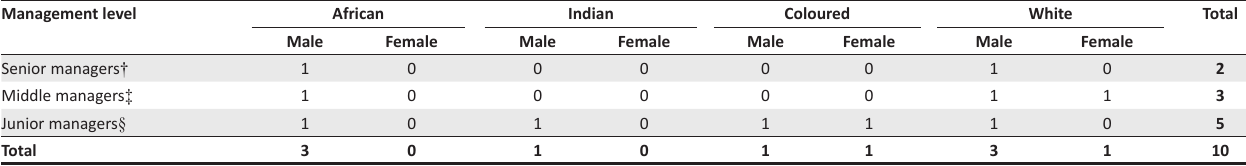
TABLE 1: Participants grouped according to management level, gender and race. Management